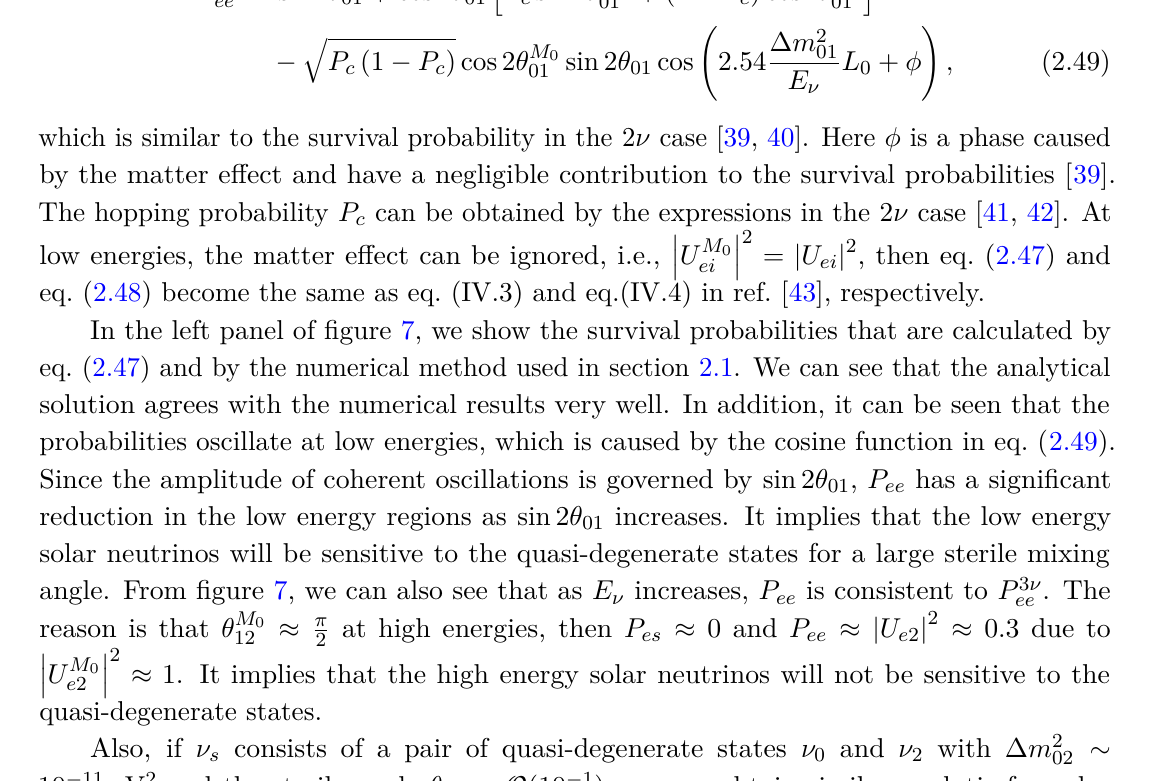
Figure 7 . Survival probability as a function of solar neutrino energy in the quasi-degenerate case. The dashed (solid) line represents the analytical (numerical) solution. ∆ m 2 1 × 10 − 11 eV 2 in the left (right) panel. The blue and cyan (red and pink) curves correspond to sin 2 2 θ 01 , 02 = 0 . 1 (1.0). Other oscillation parameters are the same as those in figure